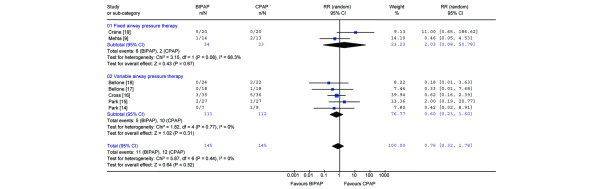
Forest plot: effect of BiPAP and CPAP on hospital mortality. BiPAP, bi-level positive airway pressure; CI, confidence interval; CPAP, continuous positive airway pressure; RR, relative risk.